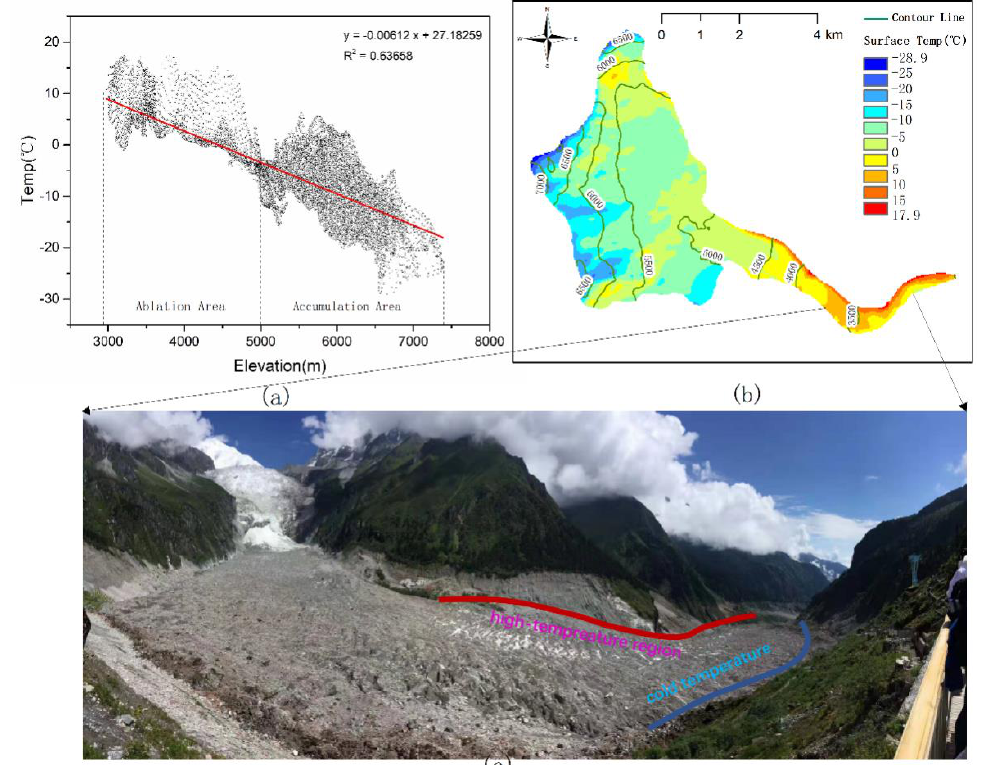
Figure 3. Spatial patterns of surface temperatures on the Hailuogou glacier in clear daylight (10 November 2018): ( a ) the variation in the GSTs with elevation; ( b ) the distribution of GSTs across the Hailuogou glacier; ( c ) photograph of the glacier tongue.